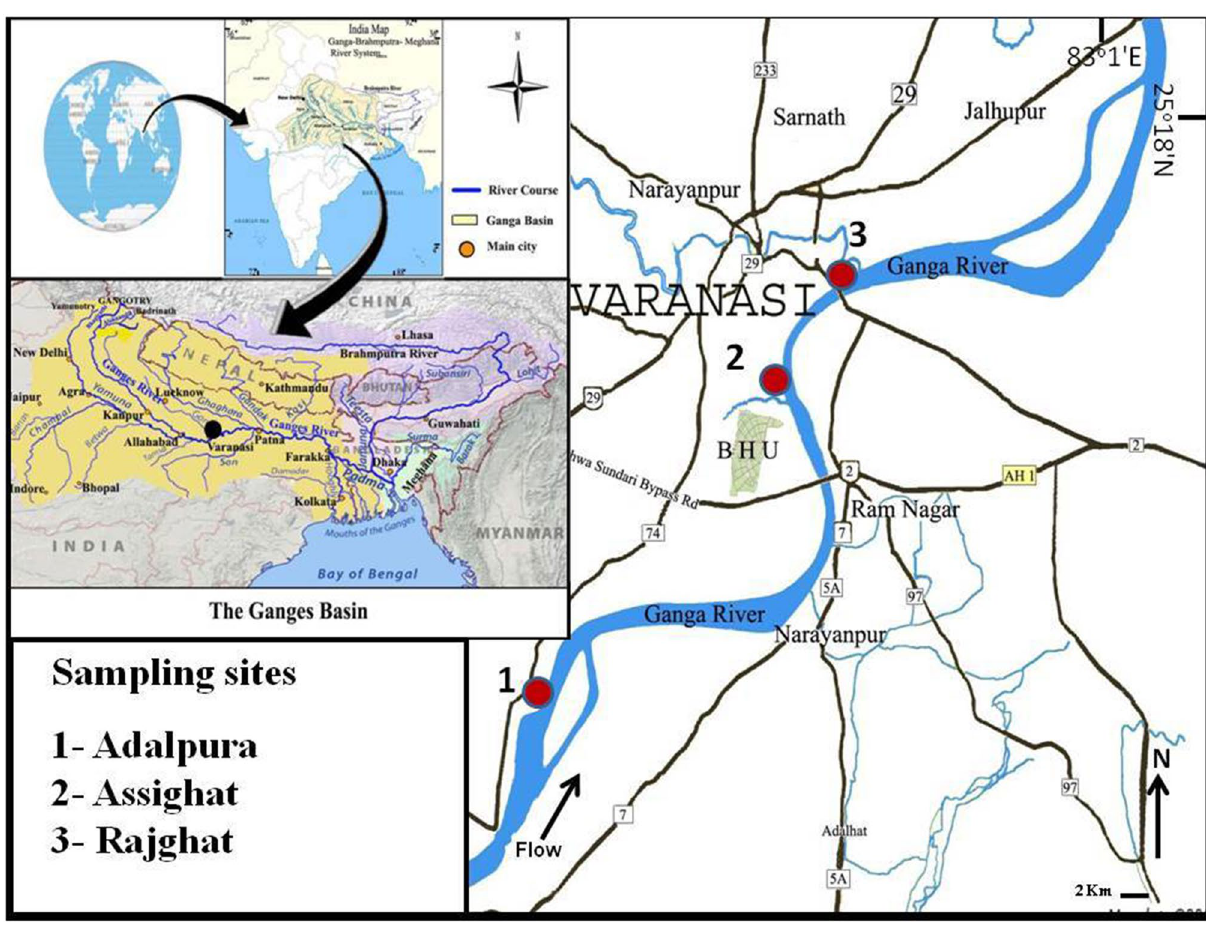
Fig. 1 Map showing sampling locations